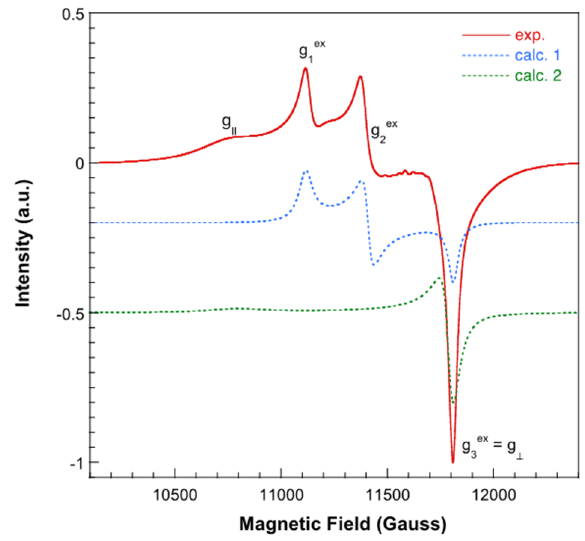
Figure 7. Q-band EPR spectrum recorded at room temperature. See text for the fitting parameters.